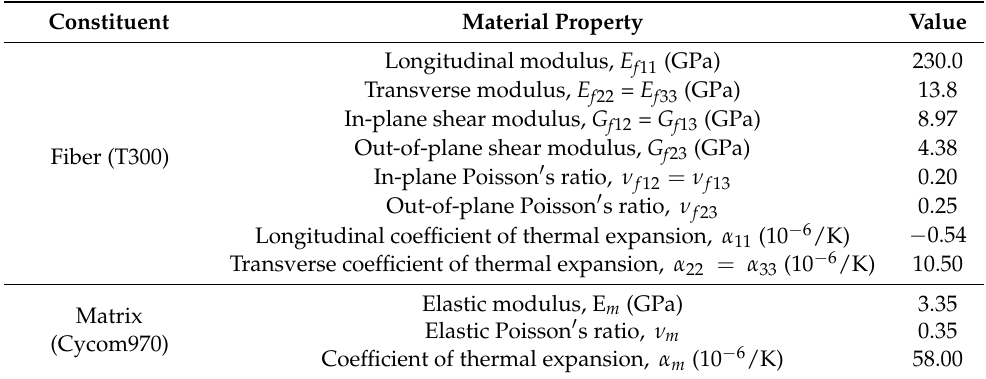
Figure 5. Hexagonal micro-scale RUCs with different values of fiber volume fraction: ( a ) RUC with fiber volume fraction of 58%; ( b ) RUC with fiber volume fraction of 78%. Table 2. Mechanical properties of the fiber and matrix constituents in the T300/Cycom970 unidirec- tional laminates.